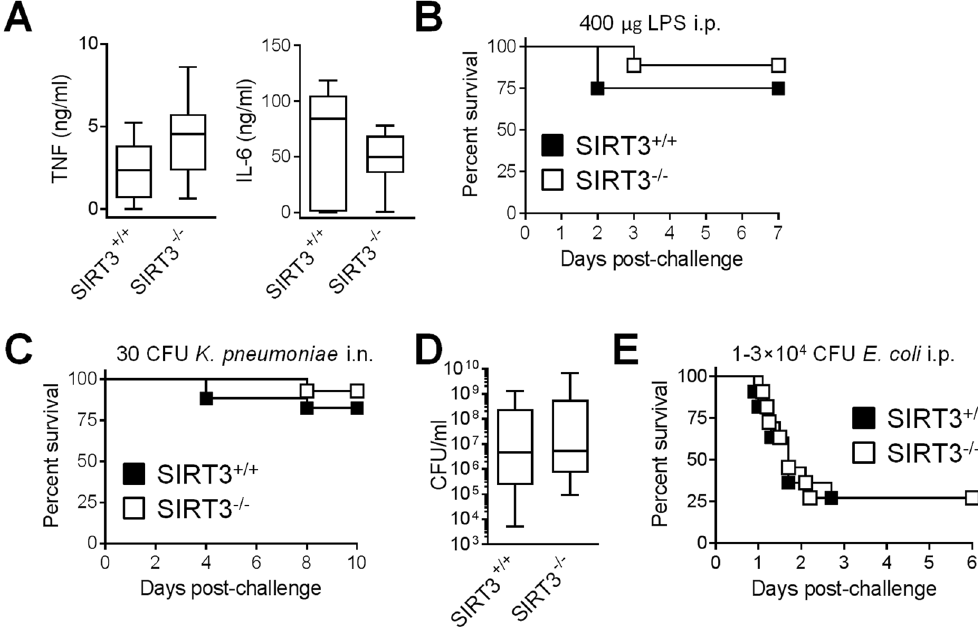
Figure 3. SIRT3 deficiency does not affect the course of endotoxemia and bacterial infection. SIRT3 + / + and SIRT3 − / − mice were injected i.p. with 400 μ g LPS (( A , B ) n = 8–9 per group), i.n. with 30 CFU K . pneumoniae (( C ) n = 17 SIRT3 + / + and 14 SIRT3 − / − mice) and i.p. with 1–3 × 10 4 CFU E . coli (( D , E ) n = 11 per group). ( A ) TNF and IL-6 concentrations in blood collected 1 hour (TNF) and 6 hours (IL-6) after LPS challenge. P = 0.1 and 0.2. ( B , C and E ) Survival of mice. P = 0.4, 0.4 and 1.0 ( D ) CFU counts in blood collected 18 hours after E . coli challenge. P = 0.4.